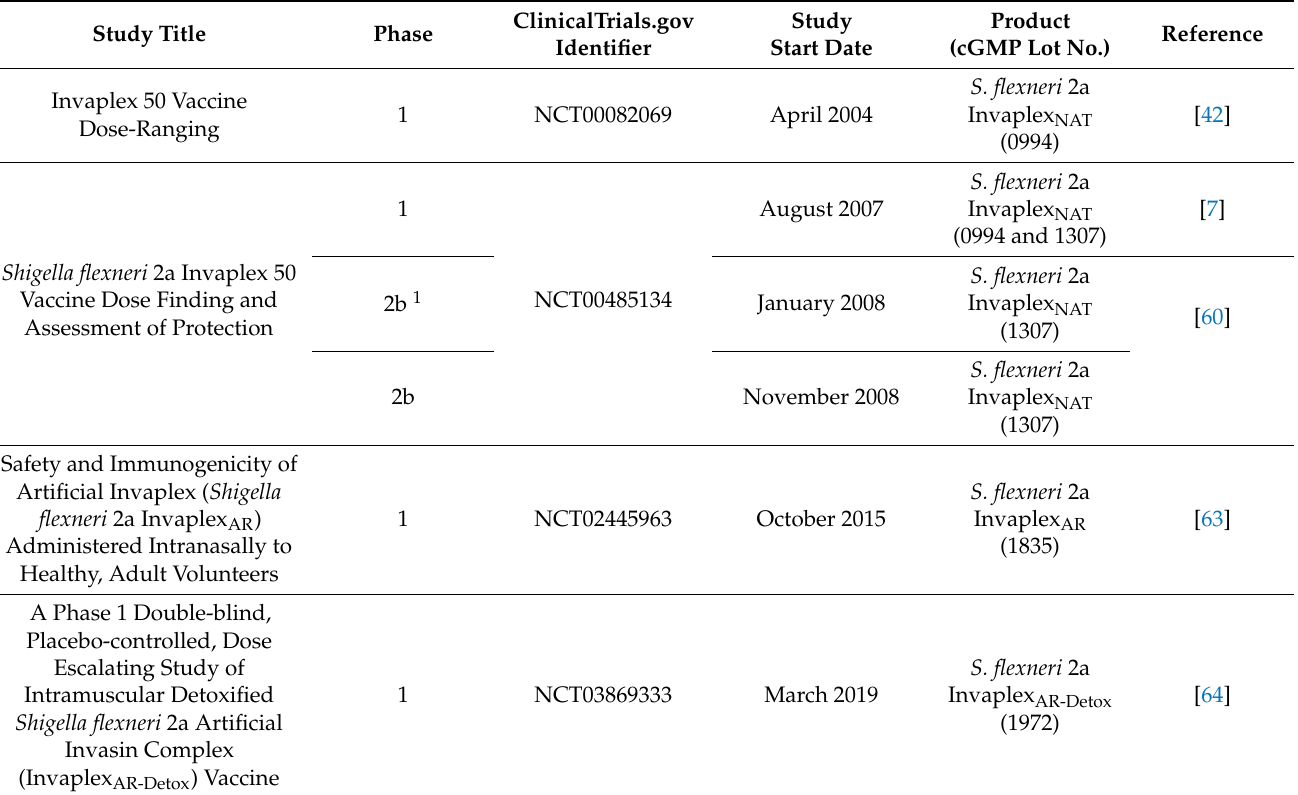
Table 3. Clinical evaluations of Shigella Invaplex vaccine